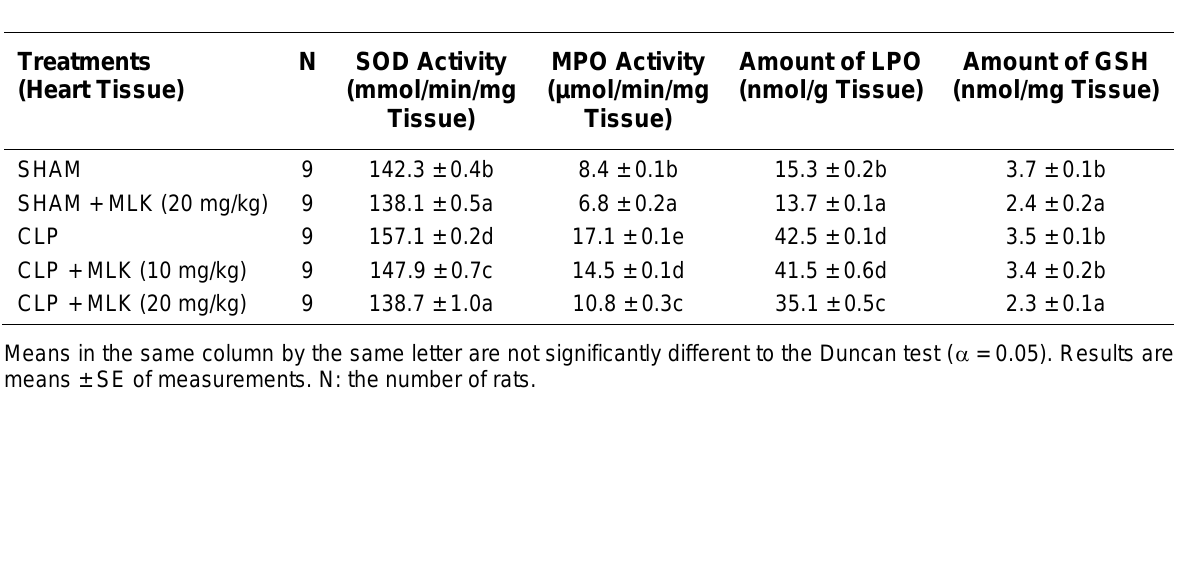
Effects of MLK Treatments on Changes in Activities of MPO and SOD, and with Levels of LPO